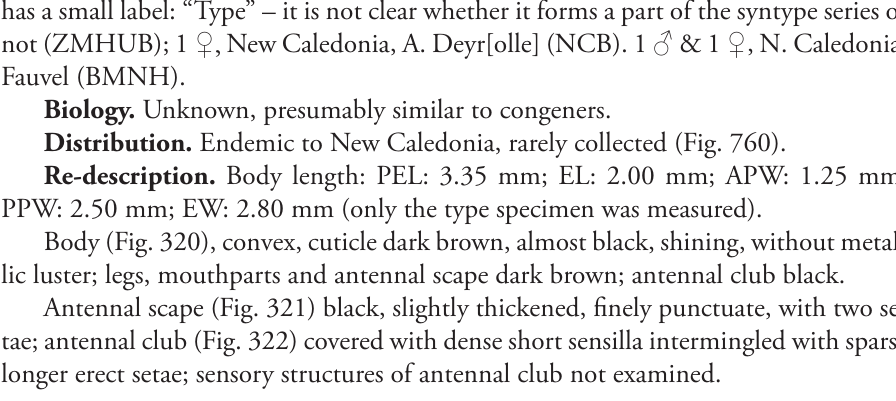
has a small label: “Type” – it is not clear whether it forms a part of the syntype series or not (ZMHUB); 1 ♀, New Caledonia, A. Deyr[olle] (NCB). 1 ♂ & 1 ♀ , N. Caledonia, Fauvel